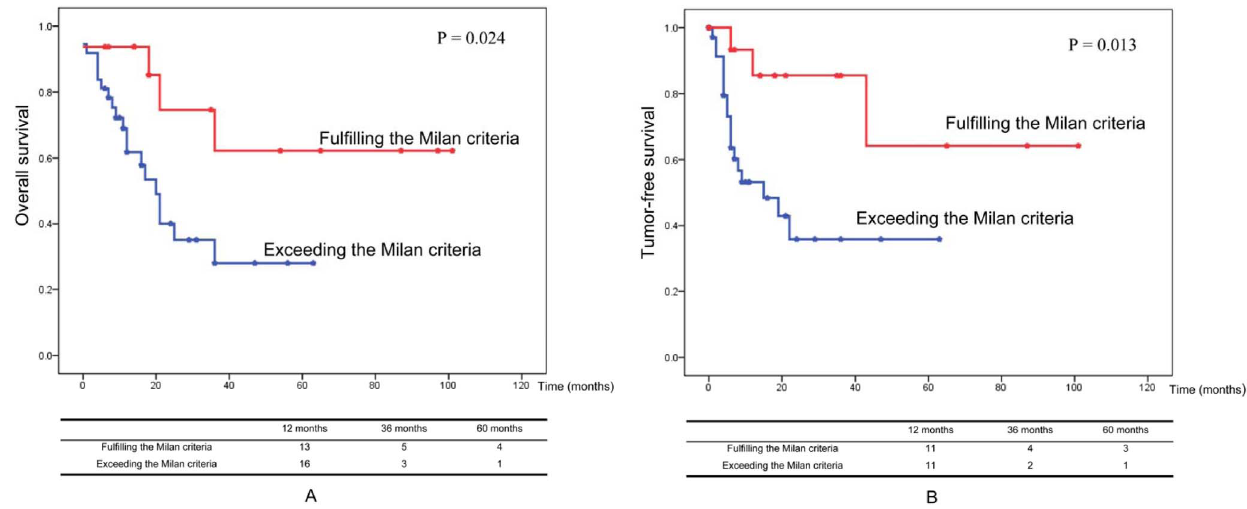
Figure 1. The Milan criteria differentiated between recipients of salvage liver transplantation. A) overall survival, B) tumor-free survival. doi:10.1371/journal.pone.0087222.g001 PLOS ONE |